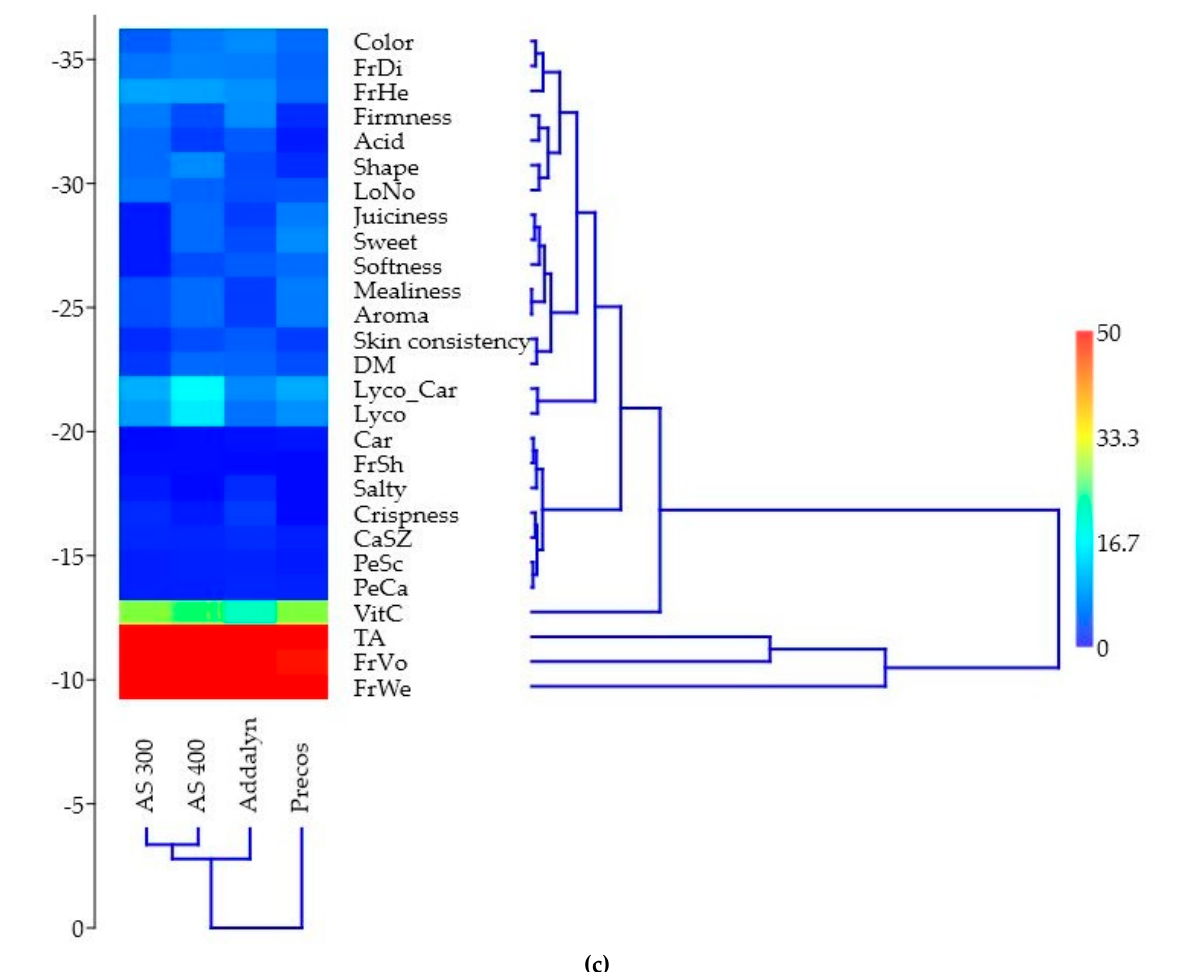
Figure 7. Multivariate analyses for the studied characteristics in the four tomato genotypes: ( a ) cor- respondence analyses performed for 42 physico-morphological and chemical traits; the following abbreviations are used: FrHe (Fruit height), FrDi (Fruit diameter), FrSh (Fruit shape index), FrVo (Fruit volume), FrWe (Fruit weight, as mean of all clusters), PeCa (Pedicel–calyx distance, as mean of all clusters), CaSZ (Calyx size, as mean of all clusters), PeSc (Peduncle scar, as mean of all clusters), LoNo (Locus number, as mean of all clusters), DM (dry matter), TA (total acidity), VitC (vitamin C), Lyco (lycopene), Car ( β -Carotene), Lyco_Car (total lycopene + β -Carotene), aroma, salty, sweet, acid, color, shape, skin consistency, mealiness, softness, crispness, juiciness, firmness; ( b ) principal compo- nent analysis (PCA) for the four tomato F1 commercial hybrids; ( c ) Ward’s hierarchical